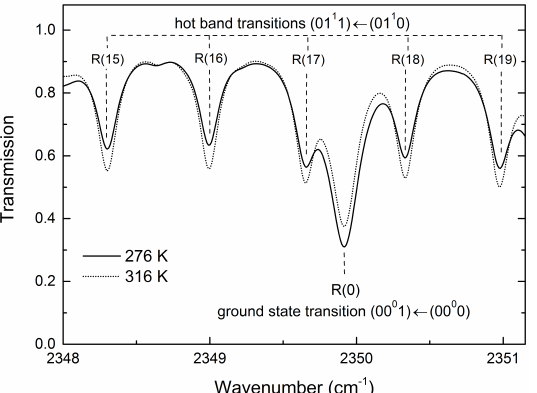
Figure 1. HITRAN-based simulated transmission spectra of CO 2 gas in air for two different tempera- tures (optical path length: 1 m, CO 2 concentration: 0.033%, p = 101325 Pa).